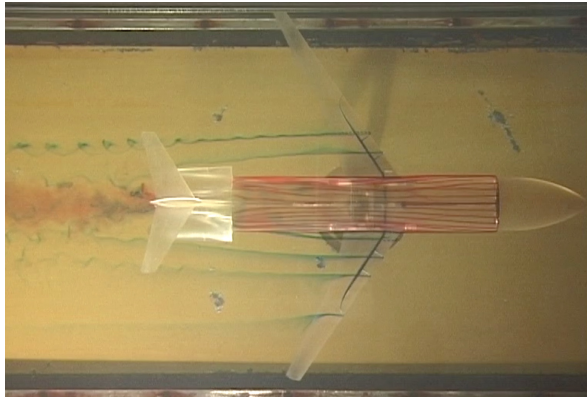
Figure 1. Flow visualization in hydrodynamic